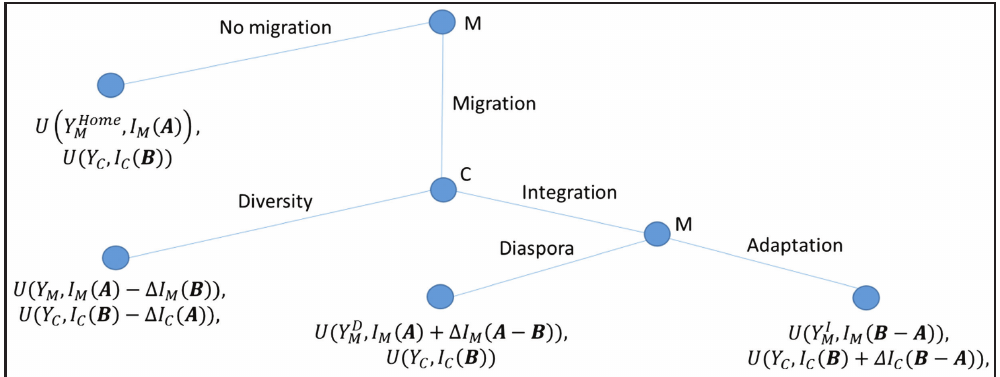
Figure 1 Akerlof-Kranton cultural identity game